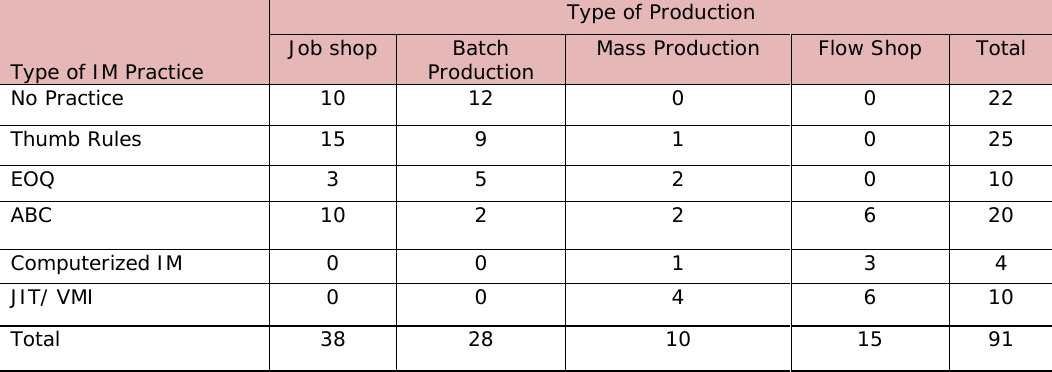
Table 4. “Type of production and IM